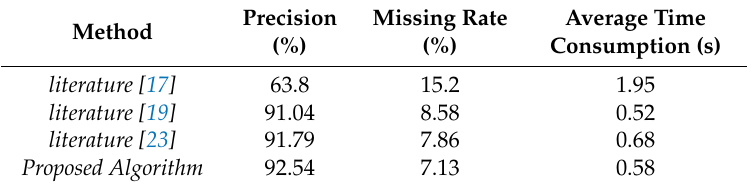
Table 1. Comparison of performances of proposed method with methods in References [17,19,23].